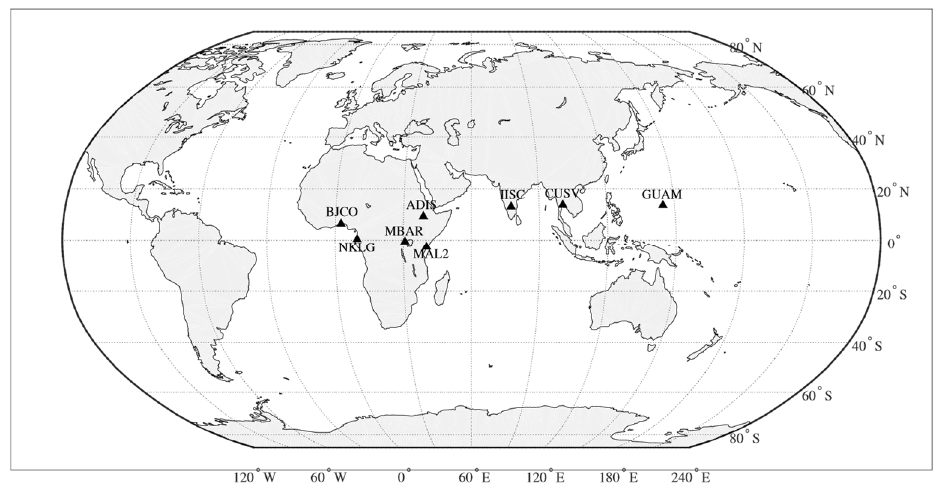
Figure 1. Geographic map of the study areas showing the global distribution of the eight GPS stations: MAL2, MBAR, NKLG, BJCO, ADIS, IISC, GUAM, and CUSV. Table 1. List of GPS Stations with Their Geographic and Geomagnetic Coordinates. Geographic Coordinates Geomagnetic Coordinates